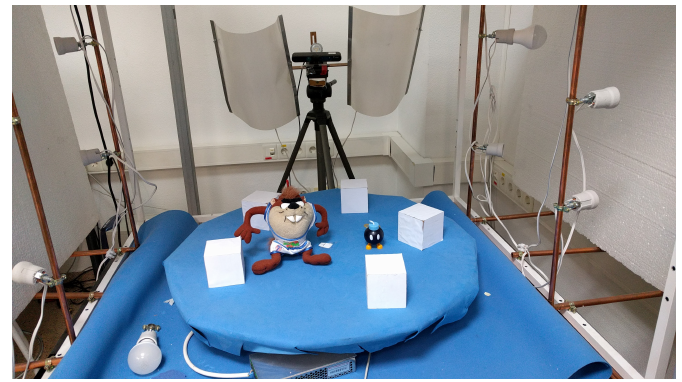
Figure 17. Controlled